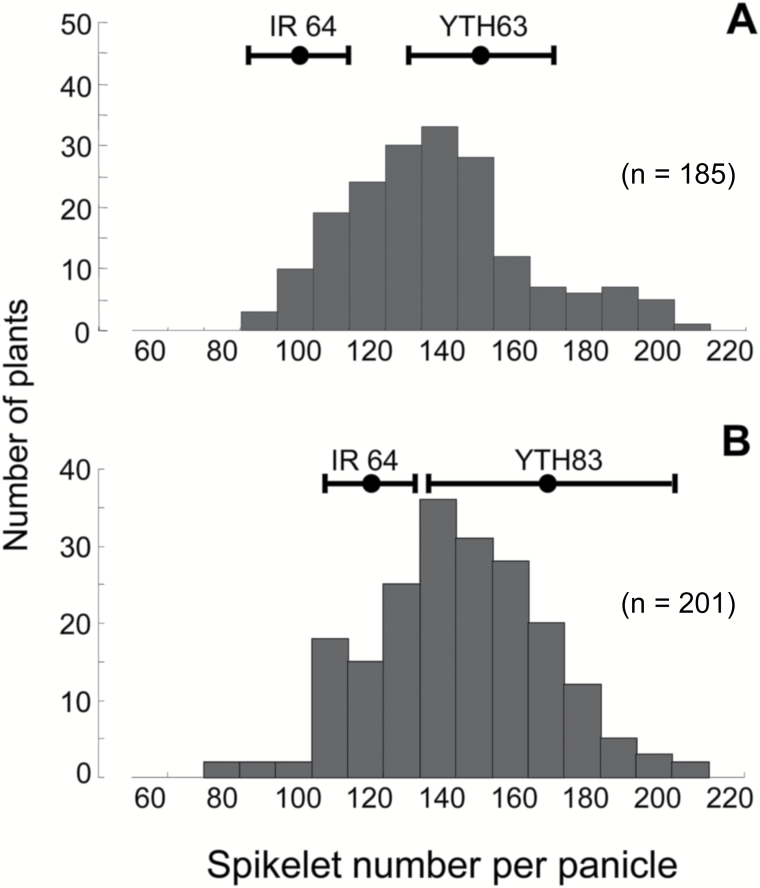
Frequency distribution of total spikelet number per panicle in BC4F2 and BC4F3 populations derived from crosses of IR 64 with (A) YTH63 or (B) YTH83.